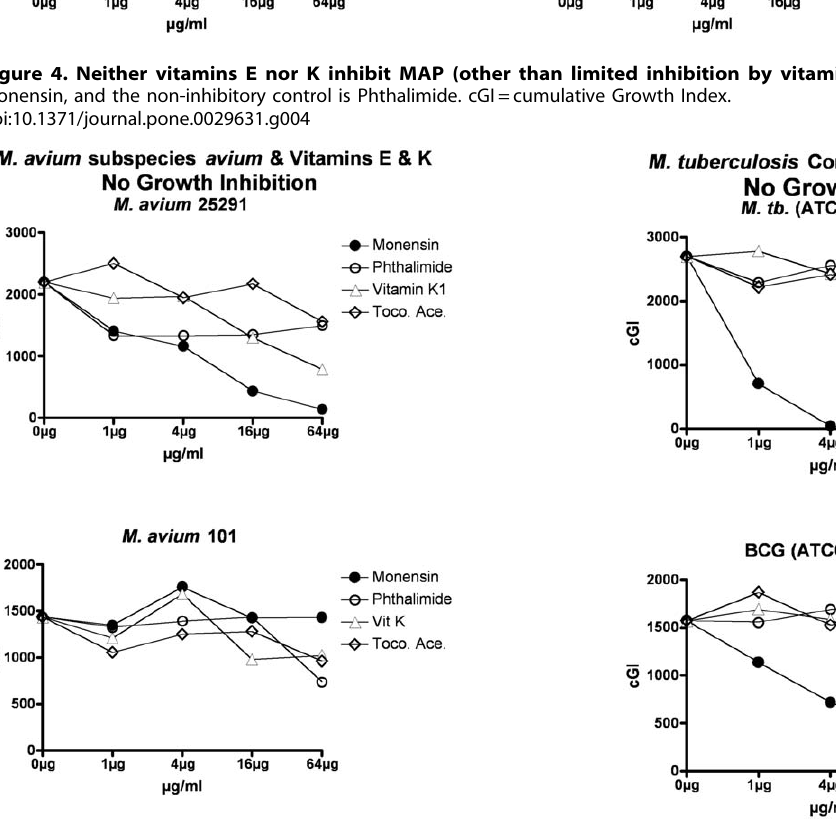
Figure 6. Neither vitamins E nor K inhibit the M.tb. complex. The inhibitory control is Monensin, and the non-inhibitory control is Phthalimide. cGI=cumulative Growth Index.